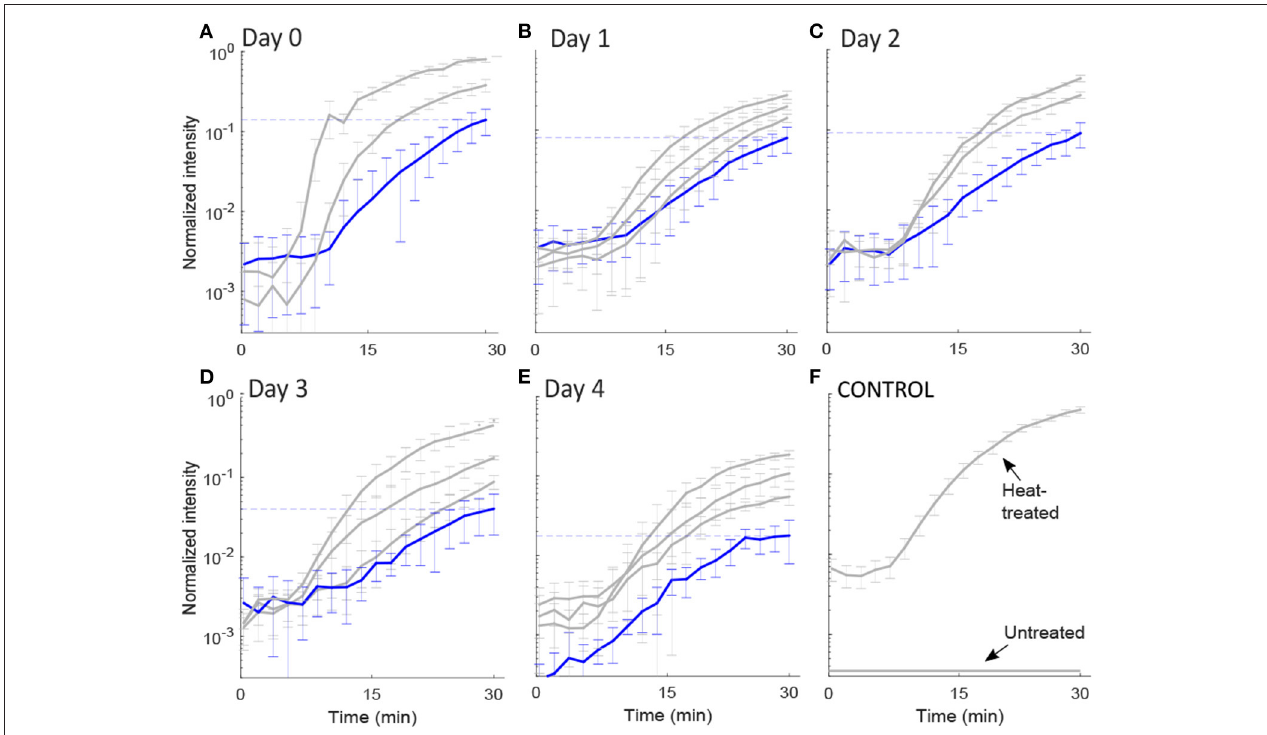
FIGURE 3 | Intensity plots. The normalized mean and standard deviation of the red fluorescence intensity, FI, emitted from: (A–E) each pressure-treated cell on days 0–4 following HPP, and (F) two control samples. The FI values were extracted from images captured by the fluorescence microscopy technique for 30 min after PI addition. We used the k-means algorithm to cluster the intensity curves through a certain number of clusters (determined by the elbow method) for days 0, 1, 2, 3, and 4 after pressure exposure based on the rate of PI diffusion through membrane pores (see 2.2). The y-axis is in log scale. The intensity value after 30 min for the group of cells with the lowest slope (shown in blue) decreased with the days from 0.14 to 0.02, represented by the dashed lines. Intensity values for each cell (raw data) are available in Supplementary File 1 .